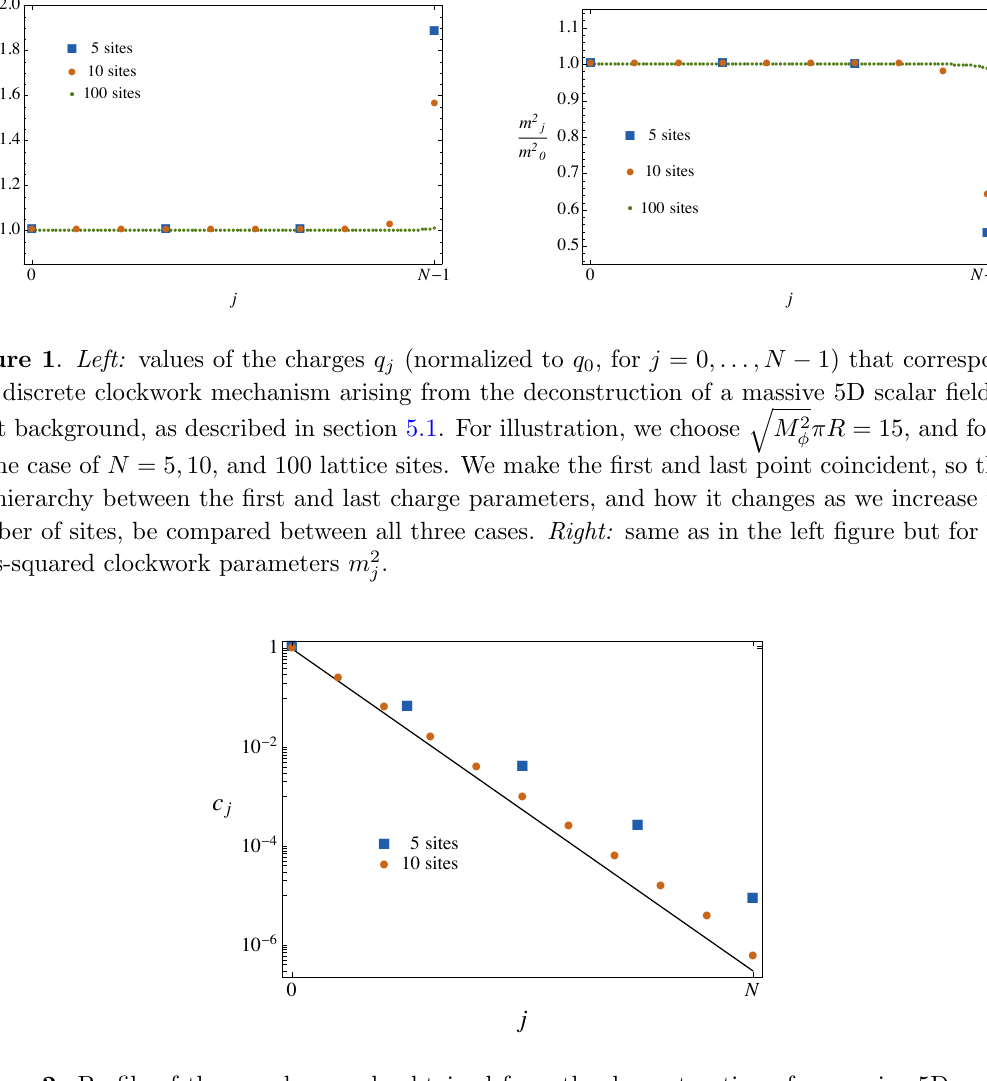
Figure 2 . Pro(cid:12)le of the massless mode obtained from the deconstruction of a massive 5D scalar (cid:12)eld in a (cid:13)at background, as described in section 5.1, for the case of N = 5 and 10 lattice sites, and q for M 2 (cid:25)R = 15 for illustration. The black line corresponds to the case of an exact exponential (cid:30) p M 2 (cid:30) y pro(cid:12)le / e (cid:0)